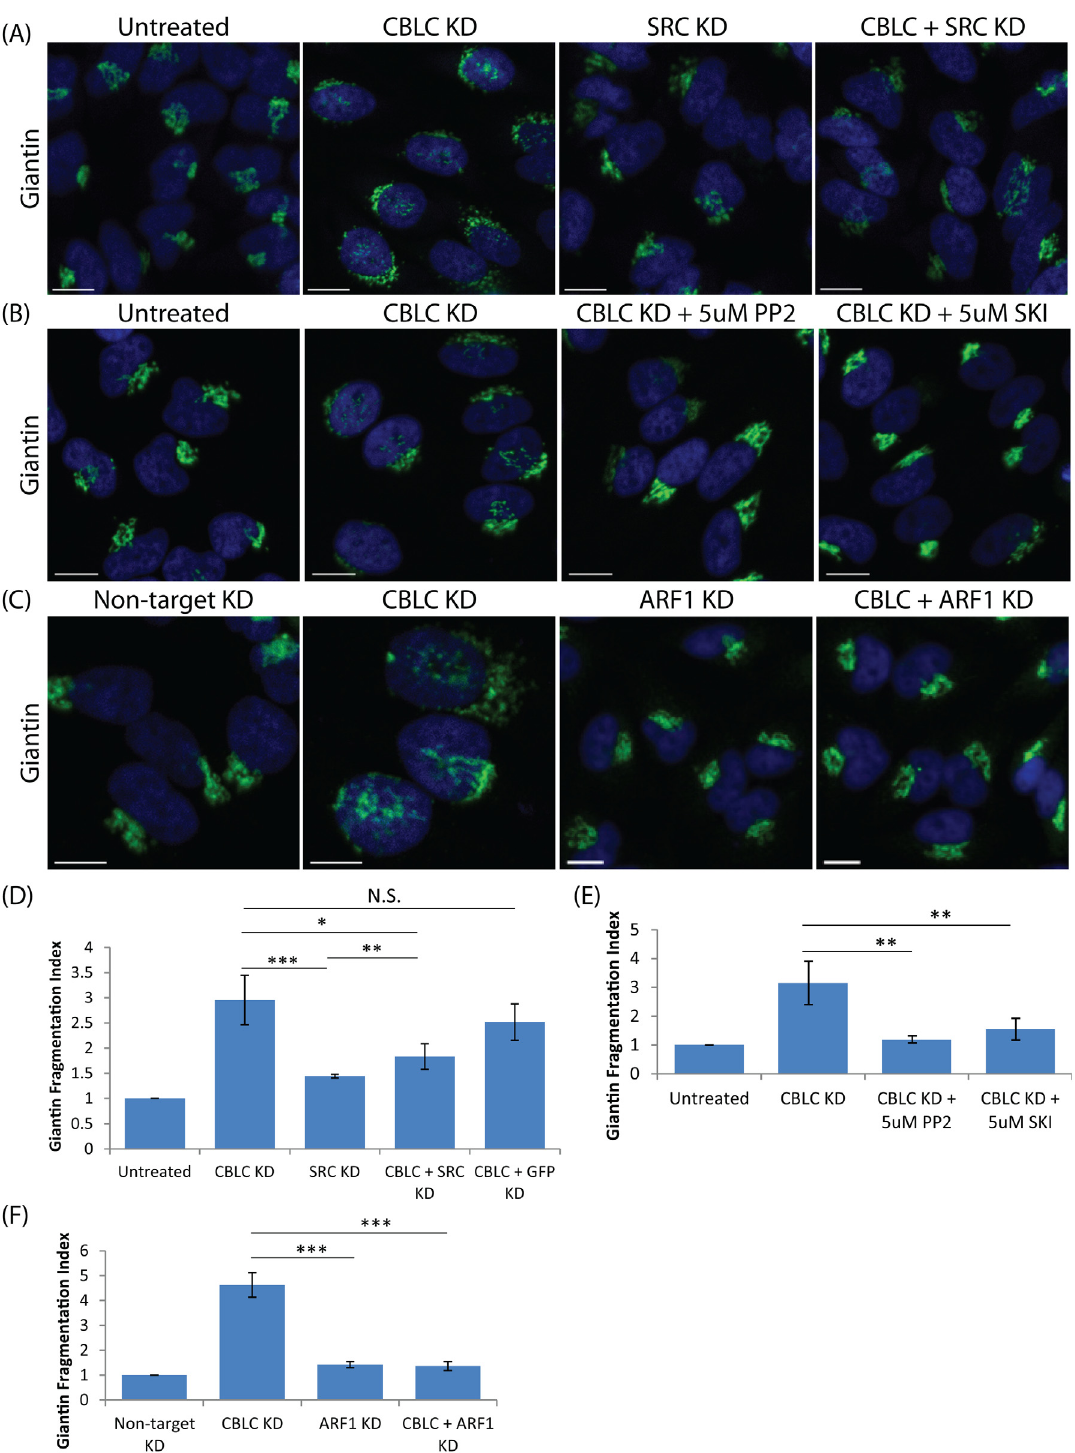
Fig 3. CBLC and SRC antagonistic effect on the Golgi apparatus. Giantin staining in HeLa cells. Fragmentation Index measured in quadruplicates on at least 400 cells per condition. Error bars show SD statistical significance (p) measured by unpaired Student ’ s t-test. ( * ) represents p < 0.05, ( ** ) represents p < 0.01 and ( *** ) represents p < 0.001. (A and D) Co-transfection of CBLC and SRC siRNAs in HeLa cells (B and E) Treatment of CBLC-depleted cells with SRC inhibitors PP2 or SKI-1 rescues Golgi morphology. (C and F) Co-transfection of CBLC and ARF1 siRNAs in HeLa cells rescues Golgi morphology. Scale bar = 10 μ